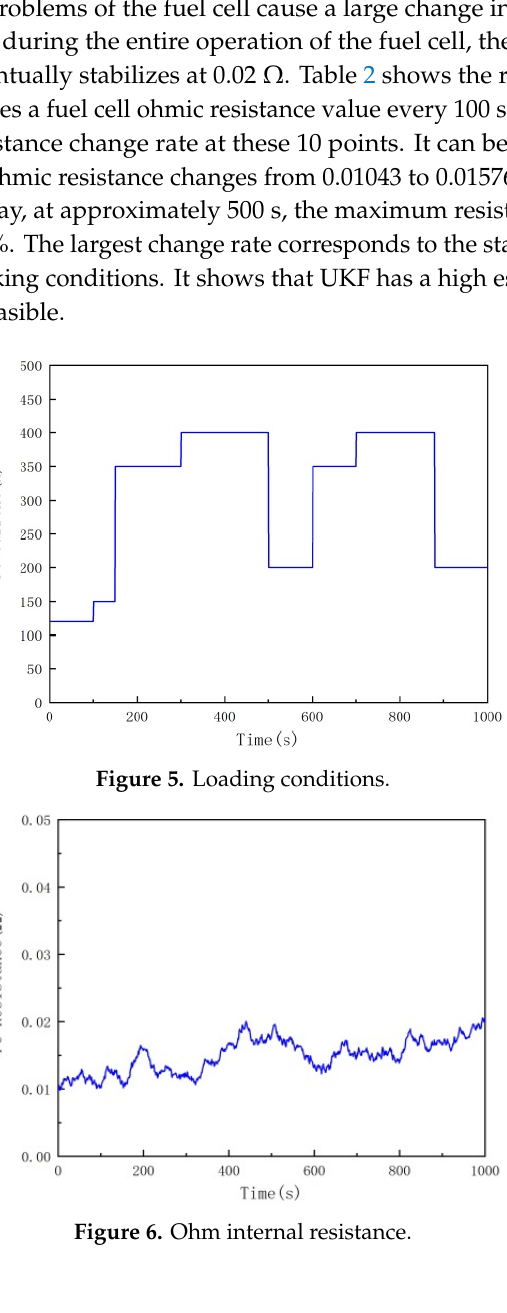
Figure 4. Test equipment. Table 2. The rate of change of the ohmic resistance.